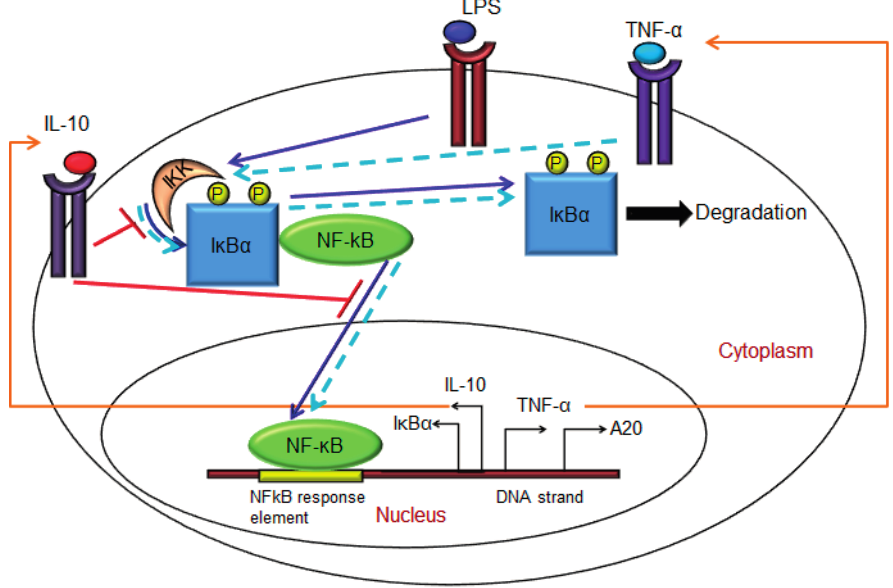
Figure 1. Schematic representation of NF- κ B signal transduction pathway under LPS stimulation in macrophages. LPS binds to cell-surface TLR4, forms the LPS-TLR4 complex that initiates activation of IKK, subsequent rapid phosphorylation and dissociation of the cytoplasmic NF- κ B translocates into the nucleus, binds to DNA response elements and initiates the transcription of target genes TNF- α , IL-10, I κ B α and A20. De novo synthesized TNF- α and IL-10 are secreted into the cell culture supernatant, where they bind to their respective cell surface receptors and initiate their positive (TNF- α ) and negative (IL-10) feedback regulations on NF- κ B. The LPS-induced NF- κ B signaling pathway is indicated in solid blue arrows. TNF- α -induced positive feedback regulation of NF- κ B is indicated in dashed cyan arrows, and IL-10-induced negative feedback regulation of NF- κ B is indicated in solid red